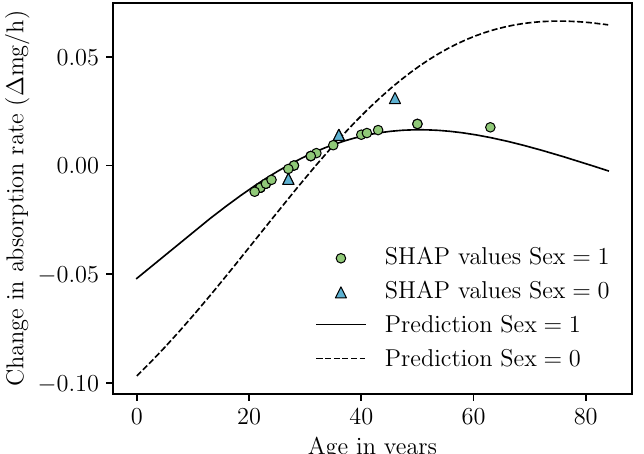
Figure 4. Examples of using SHAP for model interpretation. Change in warfarin absorption rate ( ∆ mg/h) prediction by the neural network as estimated by SHAP values. Here, circles represent the SHAP values calculated for men, whereas triangles represent SHAP values calculated for female patients. Lines represent the neural network predicting when fixing patient sex (solid for male, and dashed for female) and predicting absorption rate based on different values for